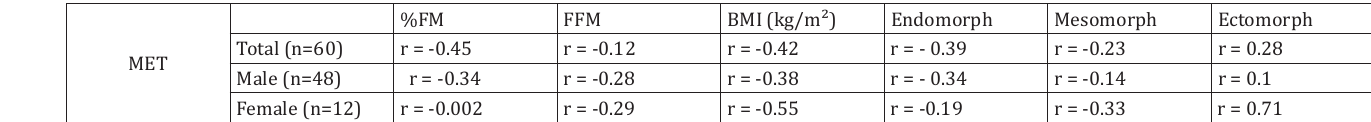
Correlations between exercise capacity and somatotype components, FM, FFM, and BMI